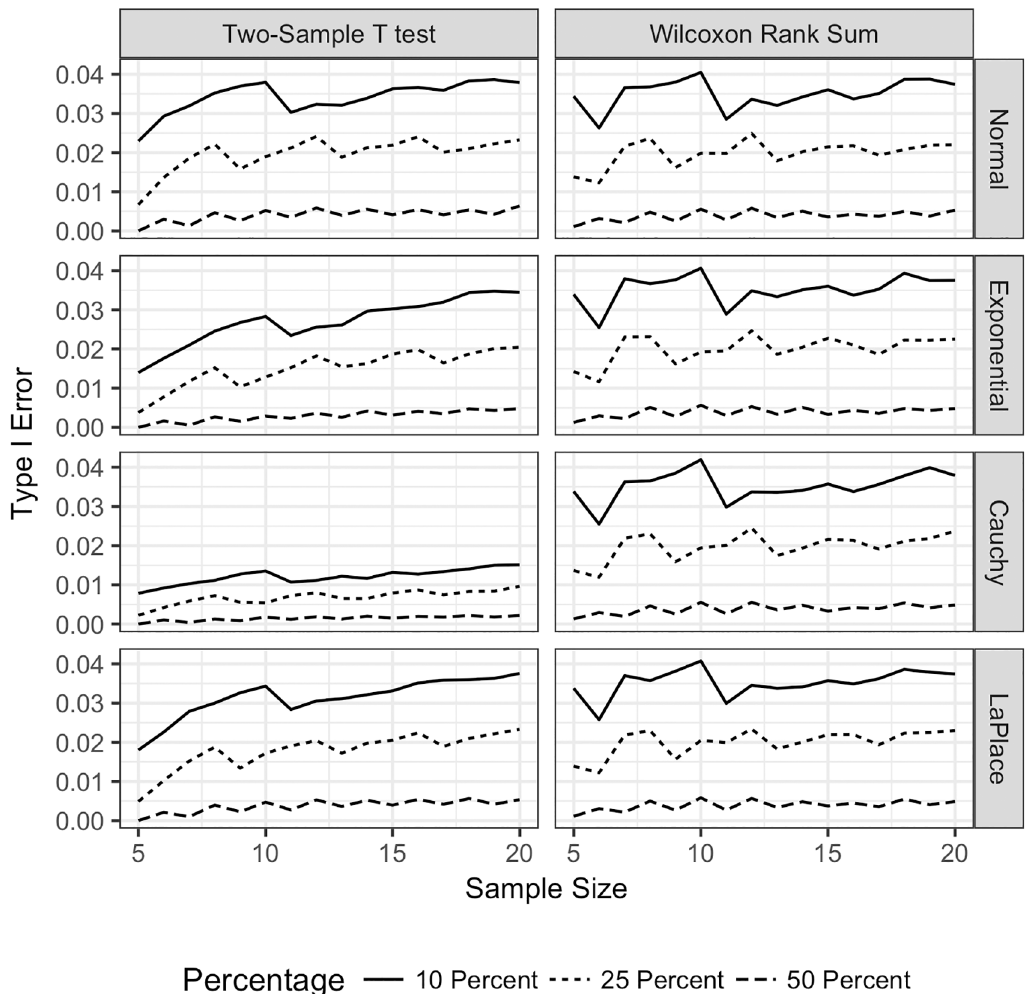
Fig 7. Type I error for TST and WMW with jittering method. Type I error for both the TST and WMW for the jittering method when 10% ( ) , 25% ( ) , and 50% ( ) , of the observations are tied; sample sizes are equal; and all distributions are continuous. Type I error is plotted on the vertical axis, and the sample size for one of the groups is plotted on the horizontal axis. Each row corresponds to a different underlying population distribution: the Normal (top row), exponential (second row), Cauchy (third row) and Laplace (bottom row). Results for the TST are displayed in the left column; results for the WMW are displayed on the right. Each frame shows the empirical Type I error under each combination of distribution and statistical